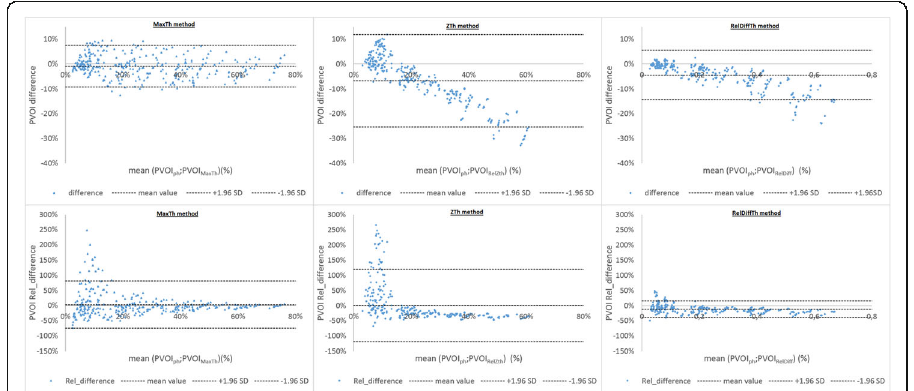
Fig. 7 Bland and Altman analysis of the three segmentation methods in terms of absolute difference (first row) and relative difference (second row). RelDiff method showed lower relative differences for medium and small PE